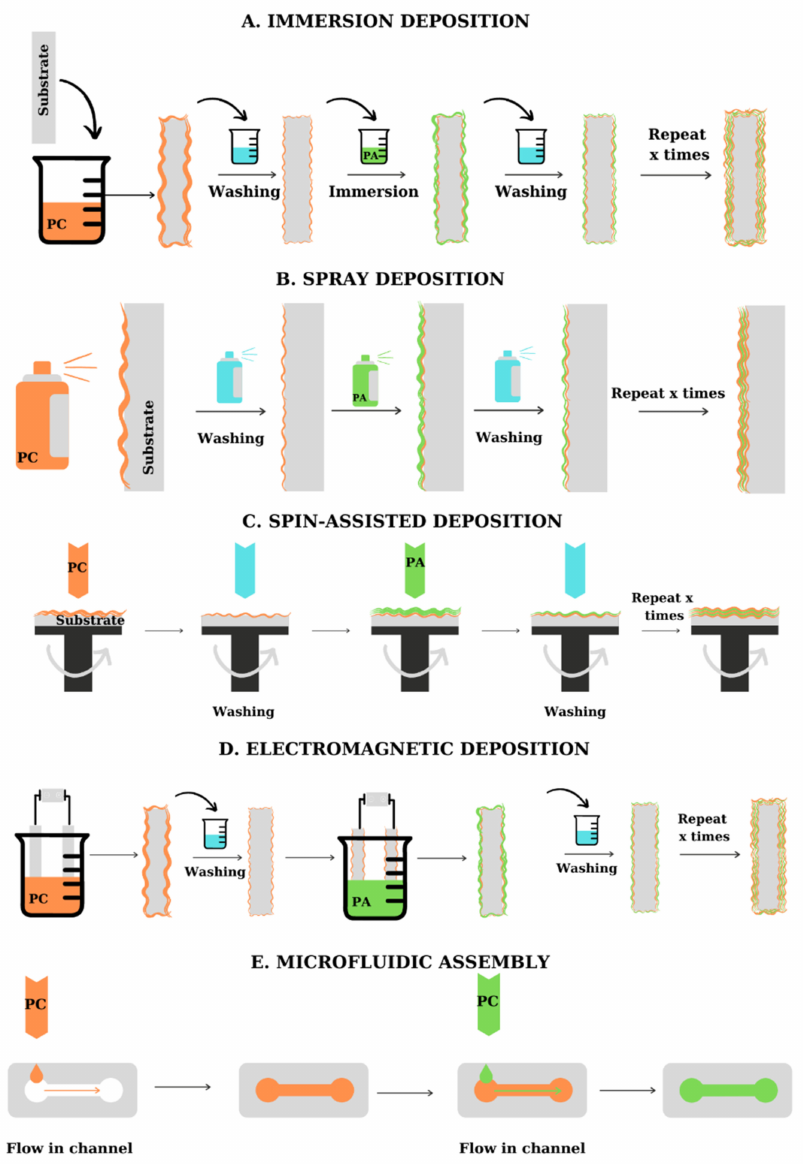
Figure 3. Schematic representation of the main LbL methods used for the fabrication of PEMs. ( A ) Conventional immersion deposition of PEs on flat substrates, ( B ) Spray deposition of PEs on flat substrates, ( C ) Spin-assisted deposition of PEs on flat substrates, ( D ) Electromagnetic deposition of PEs on flat substrates, ( E ) Microfluidic assembly of PEs on microfluidic